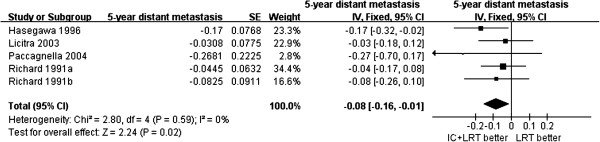
Forest plot of hazard ratios of distant metastasis-free survival and 95% CI in patients with resectable head and neck squamous cell carcinoma treated with induction chemotherapy followed by locoregional treatment, or locoregional treatment alone. Richard 1991a23 is for cancer of the floor of the mouth, Richard 1991b23 is for cancer of the posterior oral cavity and oropharynx. Hasegawa 199618, Licitra 200316, Paccagnella 200411.